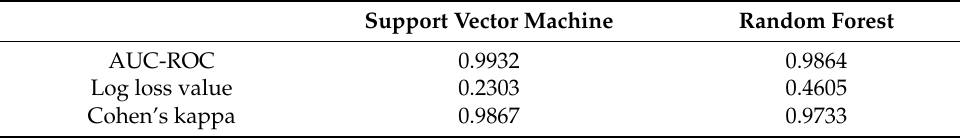
Table 5. AUC-ROC, log loss value, and Cohen’s kappa coefficient.